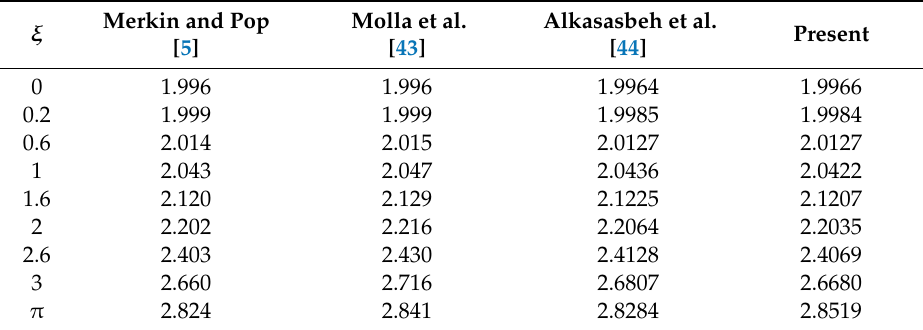
Table 2. Comparison of the current findings for surface temperature θ w ( ξ ,0 ) with prior published findings, at Pr = 1, χ = 0, M = 0, and γ → ∞